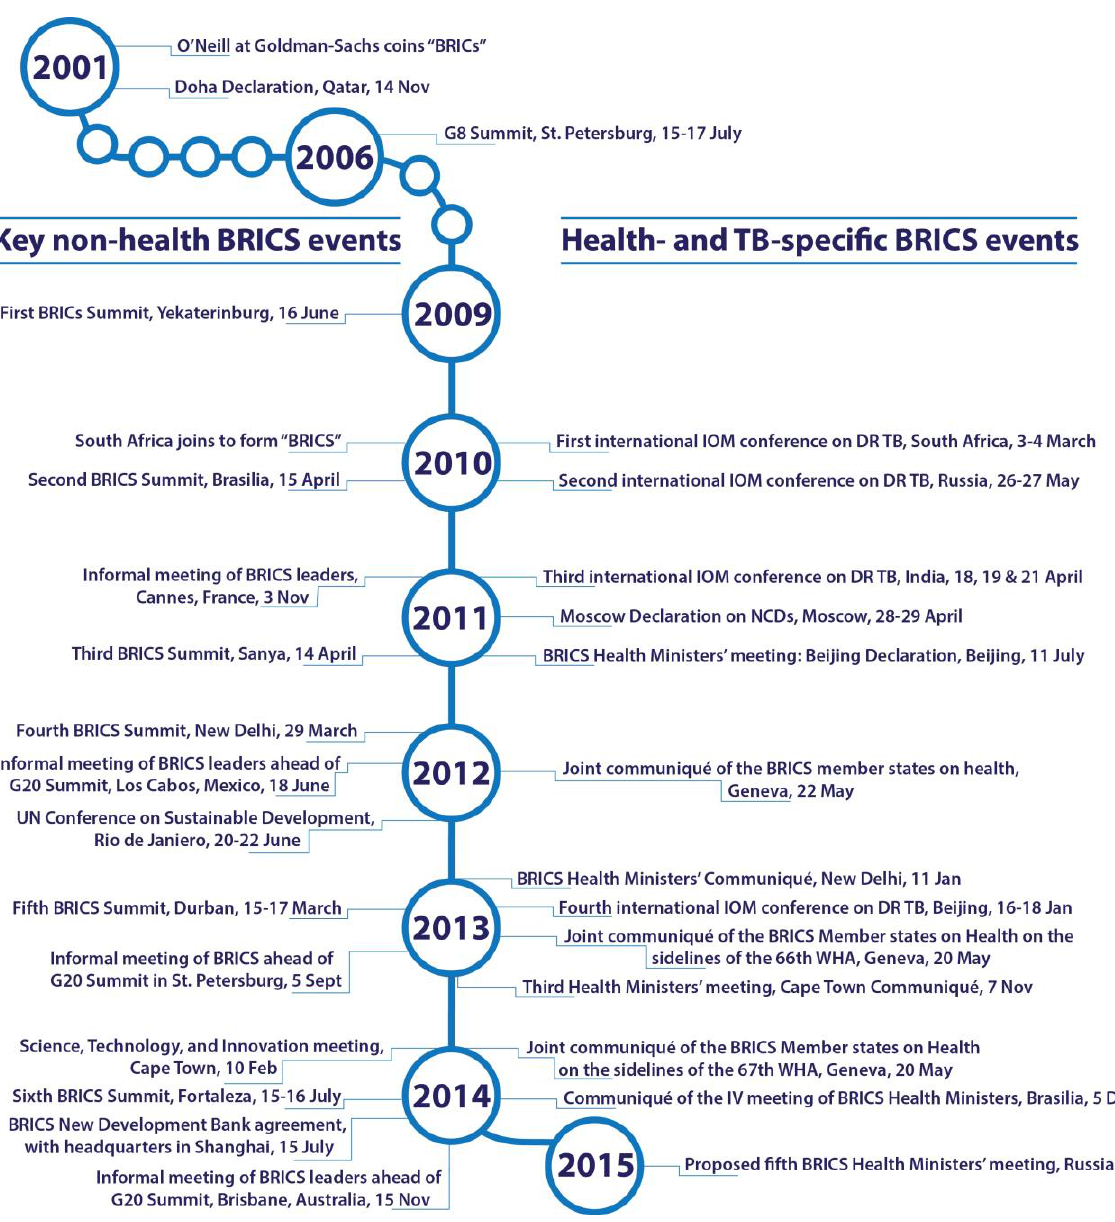
Figure 1. BRICS timeline of key health and TB-specific events. BRICs= Brazil, Russia, India, and China; BRICS= Brazil, Russia, India, China, and South Africa; DR TB = drug-resistant TB; G8/G20 = Group of 8, Group of 20; IOM = US Institute of Medicine; NCDs = noncommunicable diseases; WHA = World Health